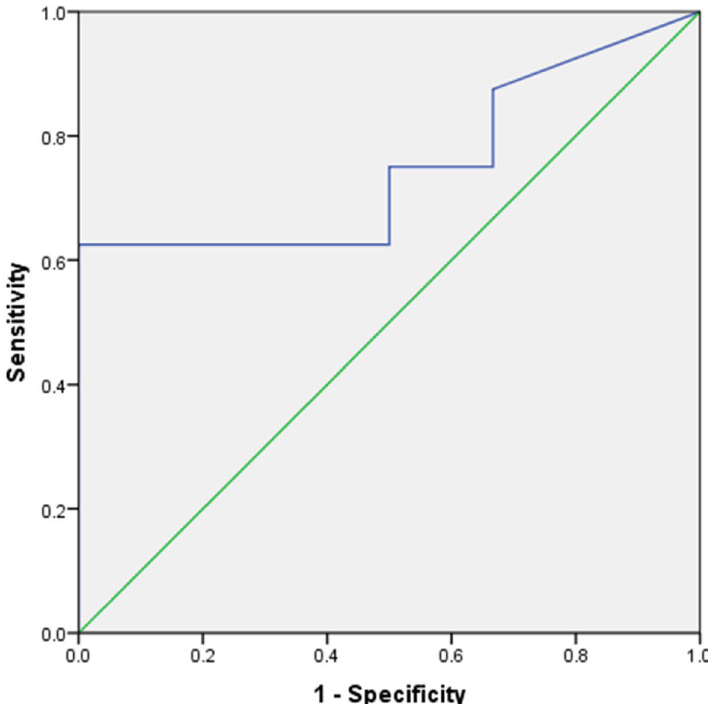
Fig. 2 Receiver operating characteristic (ROC) curve of PC1 model of serum individual bile acids for differentiating between BA and non‑BA